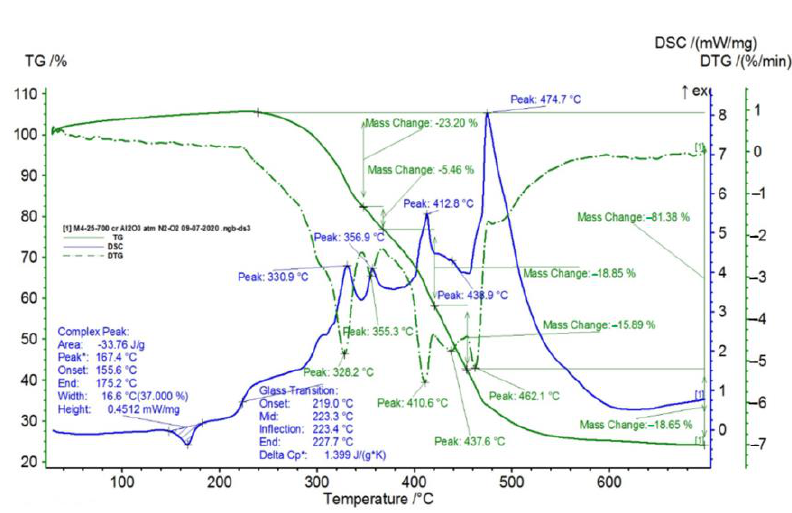
Figure 7. TG/DSC variation for sample M3.